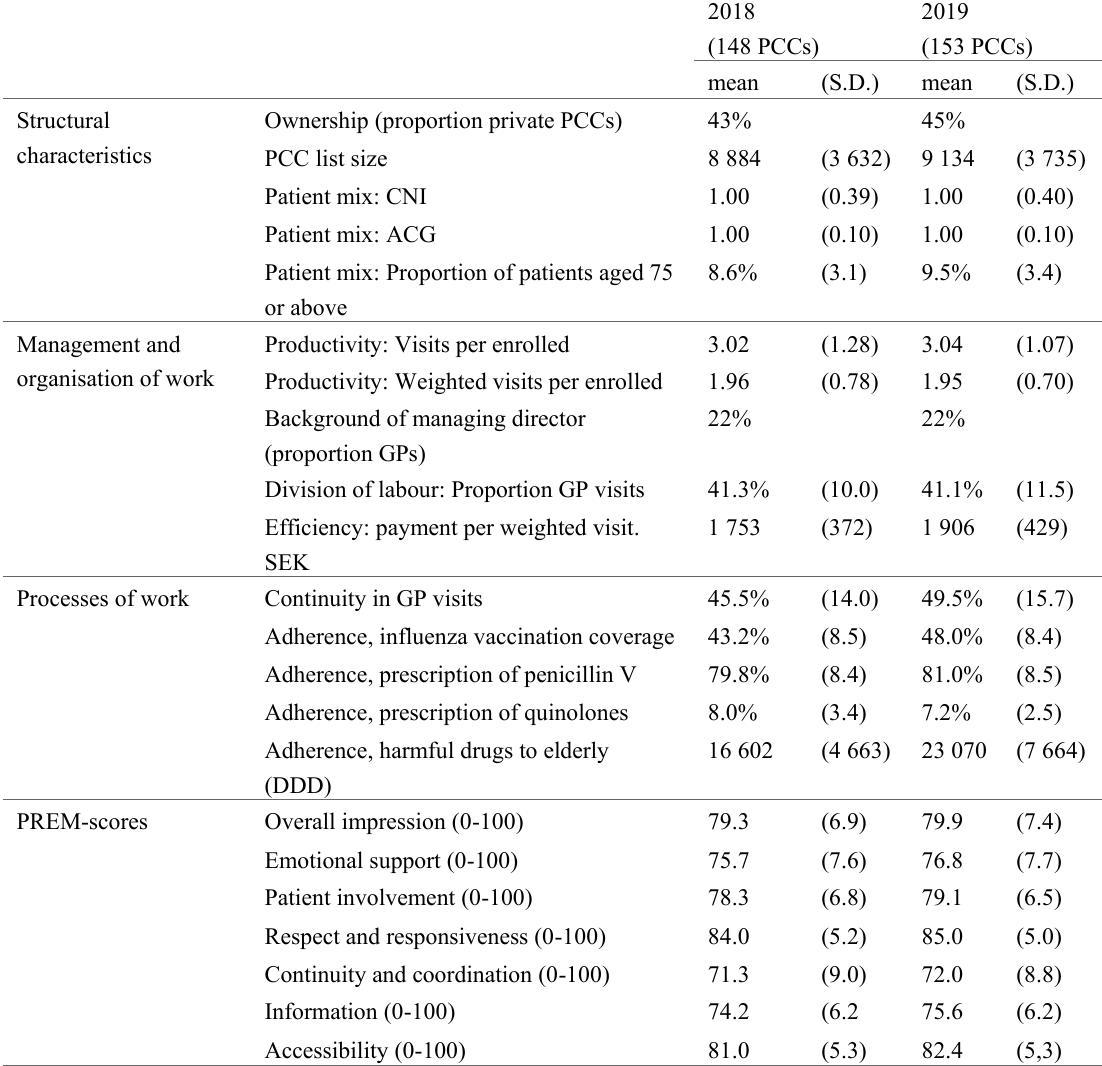
Characteristics and performance of PCCs in Region Skåne